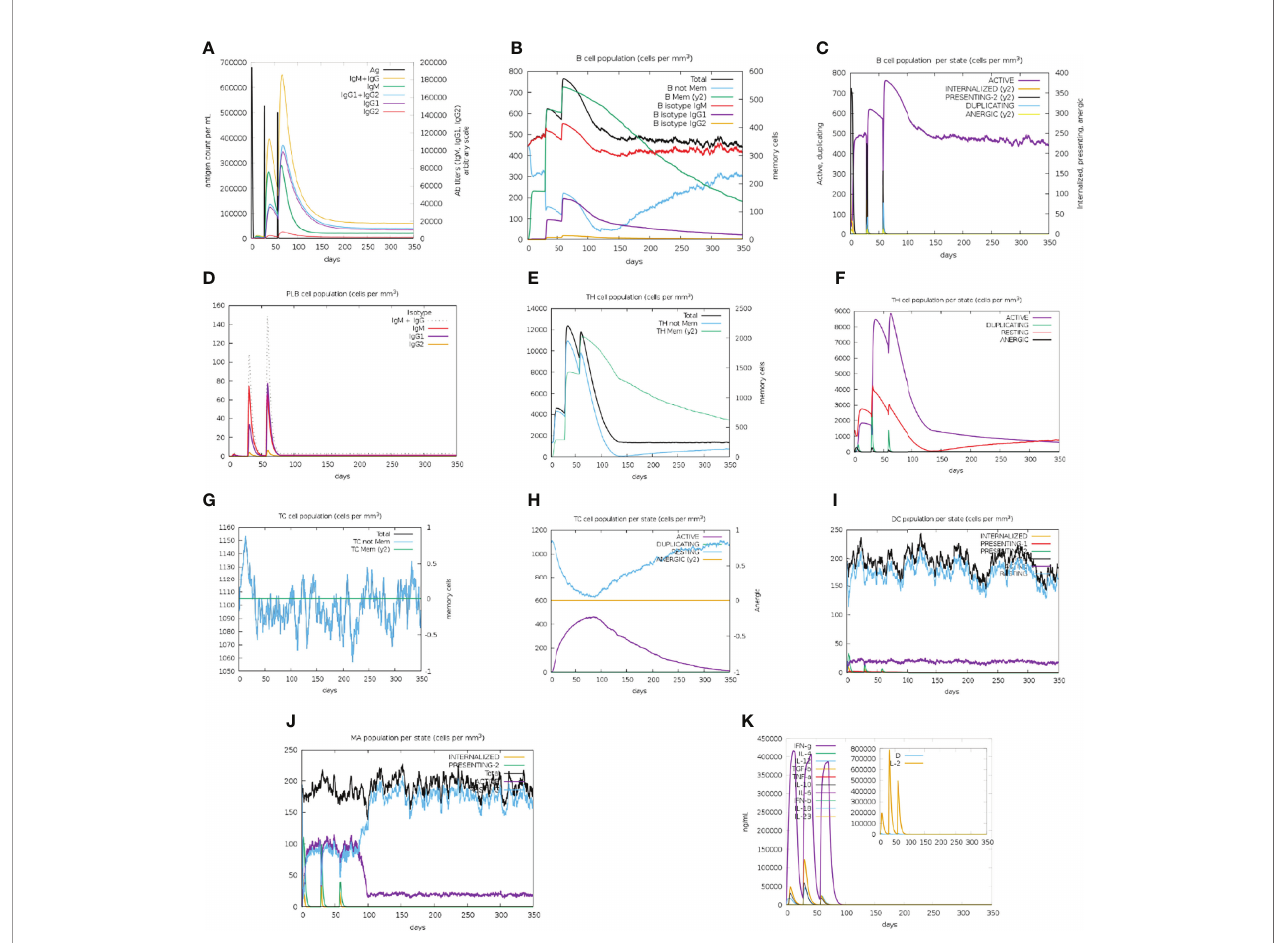
FIGURE 9 | C-IMMSIMM representation of the immune simulation of BFV. (A) The immunoglobulin and immunocomplex response to BEV administration (lines colored in black) and the subclasses are depicted by colored lines, (B) Increment in the B-cell population throughout the three injections, (C) Rise in the B-cell population per state throughout vaccination, (D) Surge in the plasma B-cell population throughout the injections, (E) Rise in the helper T-cell population throughout the three injections, (F) Elevation in the helper T-cell population per state throughout the vaccination, (G) Enhancement in the cytotoxic T lymphocyte population throughout the injections, (H) Augmentation in the active cytotoxic T lymphocyte population per state throughout vaccination, (I) Increment in the active dendritic cell population per state throughout the three injections, (J) Increase in the macrophage population per state over the course of the injections, (K) Surge in the concentrations of different types of cytokines throughout the three